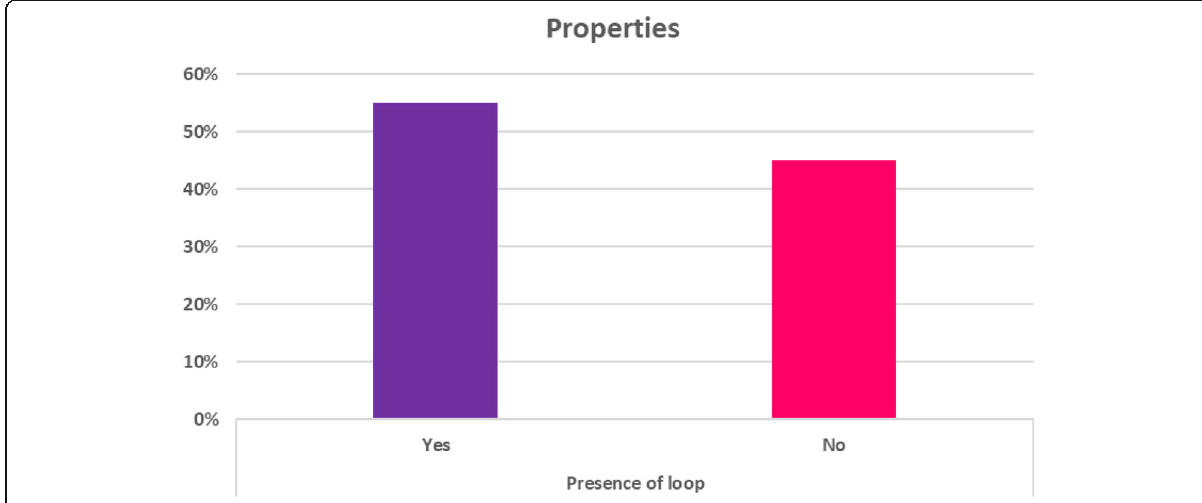
Fig. 4 Bar chart representing presence of anterior